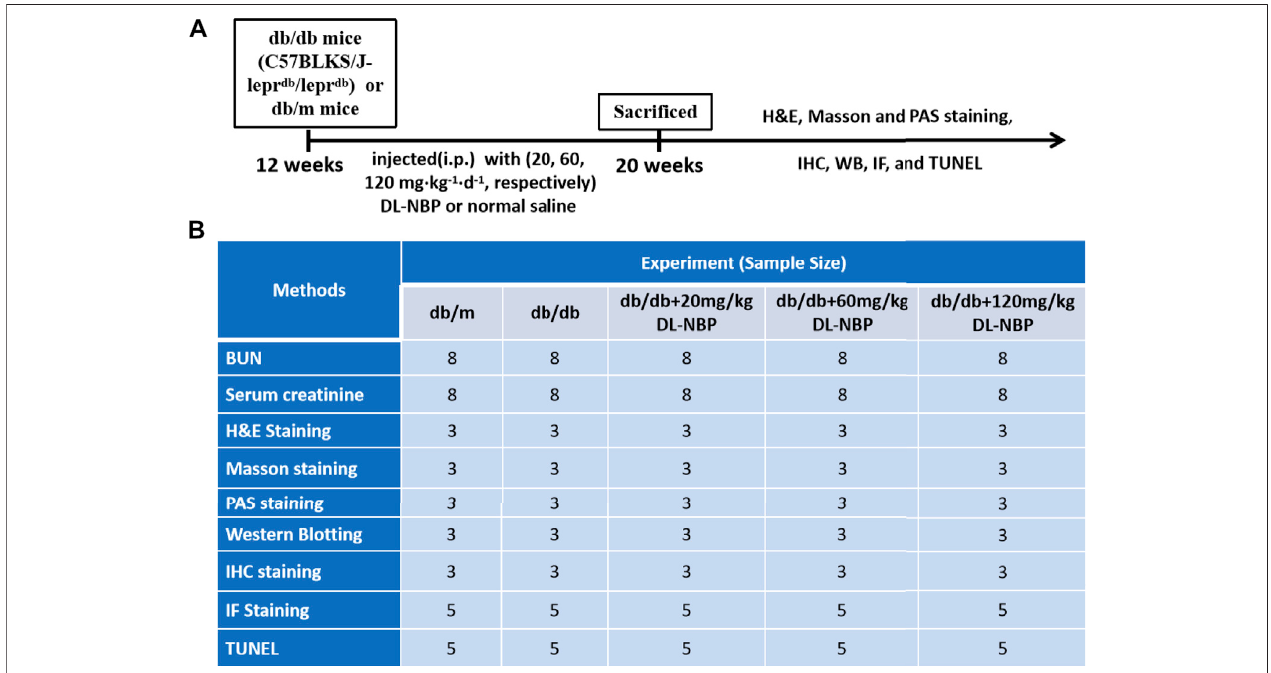
FIGURE 1| Experimental protocol ofDL-NBP treating for DN. (A) Duration of the animal study; (B) A table containing the group ofeach experiment and its sample size. BUN, blood urea nitrogen; H&E, hematoxylin and eosin; TUNEL, TdT-mediated dUTP Nick-End Labeling; WB, Western blotting; IF, immuno fl uorescence staining; IHC, Immunohistochemistry